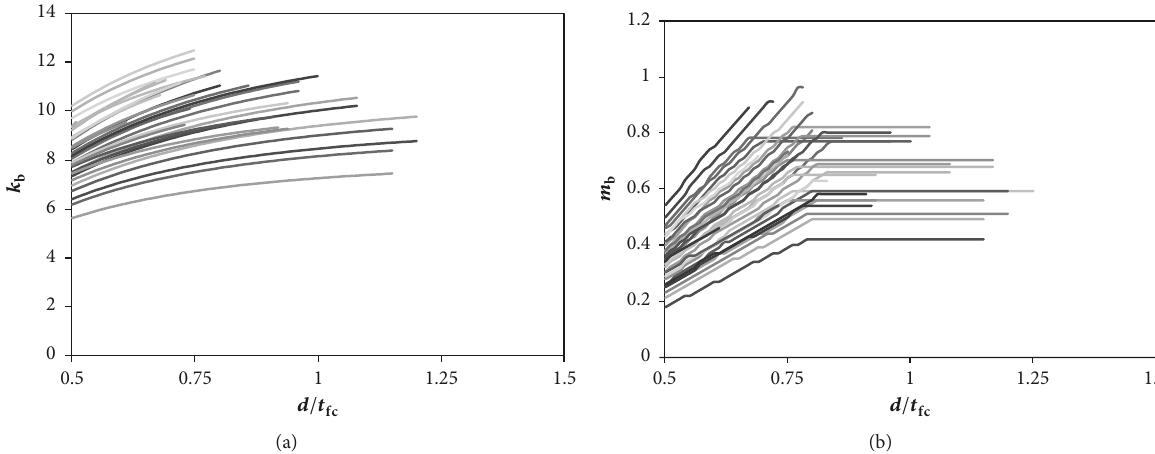
Figure 6: 𝑘 b versus 𝑑/𝑡 fc (a) and 𝑚 b versus 𝑑/𝑡 fc (b) curves for beam-to-column assemblages combining I section beams (varying from IPE 200 to IPE 750) and wide flange section columns (varying from HEM 120 to HEM 400) obtained using design